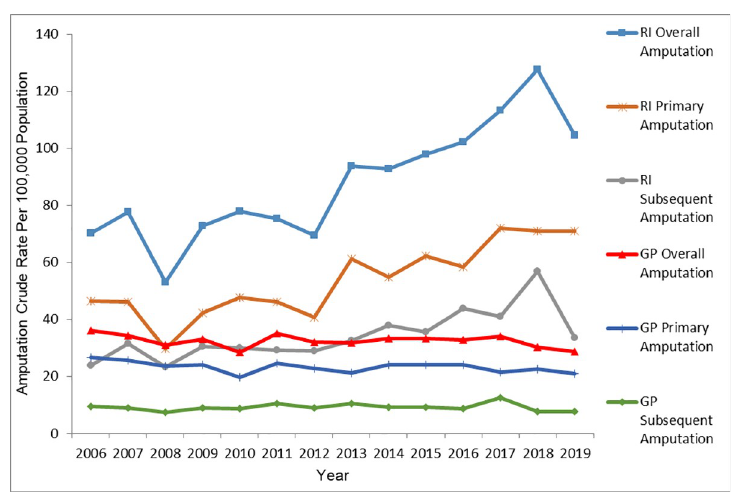
Fig 1. RI and GP overall, primary, and subsequent amputation crude rates